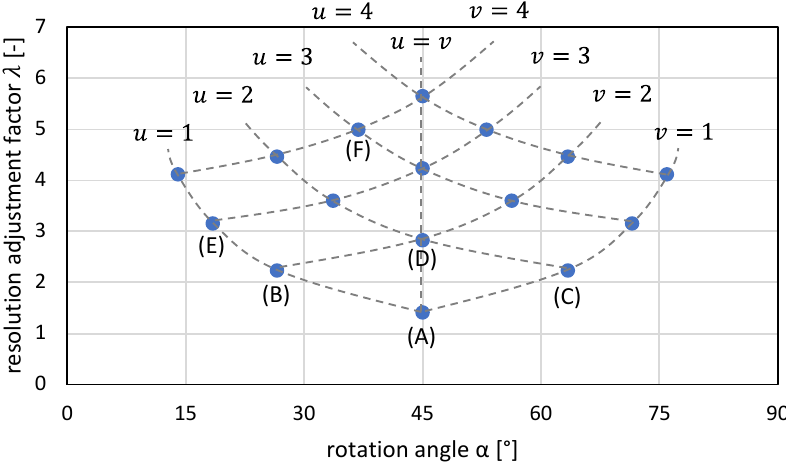
Figure 6. Association of the rotation angles and resolution adjustment factor for u – v grids with 1 ≤ u , v ≤ 4 for examples ( A – F ) according to Figure 4.